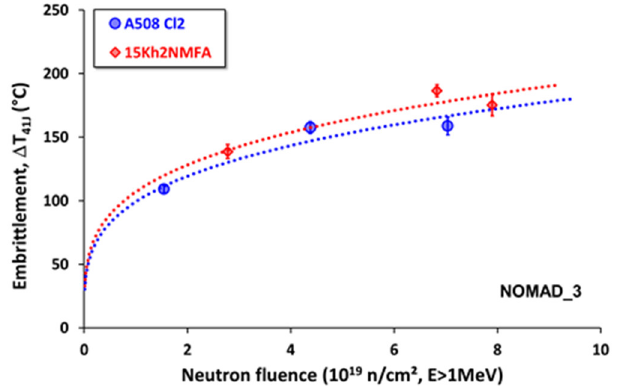
Figure 2. Embrittlement of RPV steel materials after neutron irradiation as a function of the neutron fluence. The dashed lines are added to guide the eye (power law fit) [13].